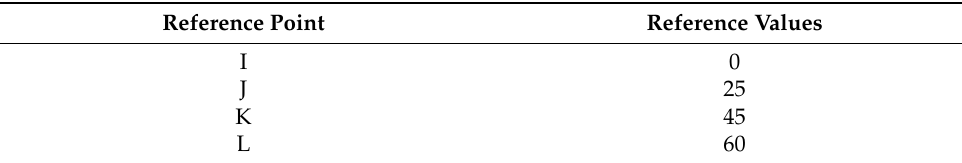
Table 2. Reference point and reference values of premise attribute 2.